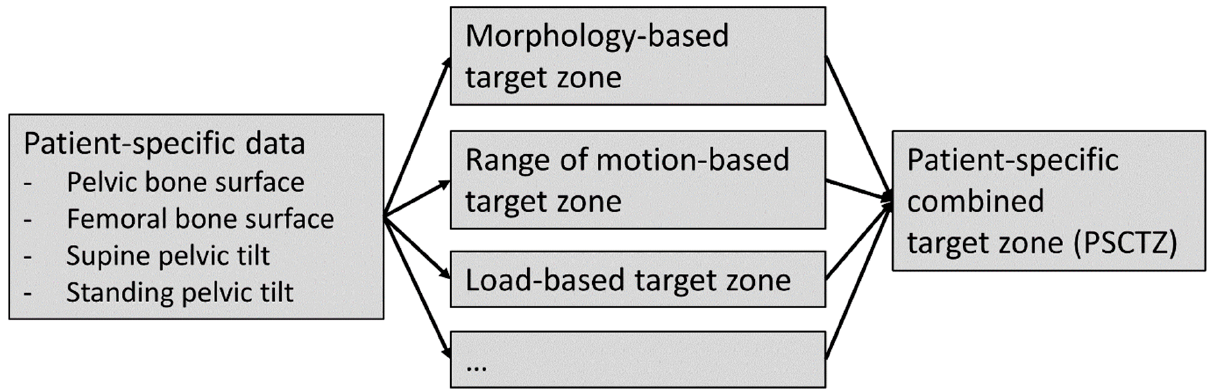
Figure 1. Overview of the concept for patient-specific combined target zone calculation.